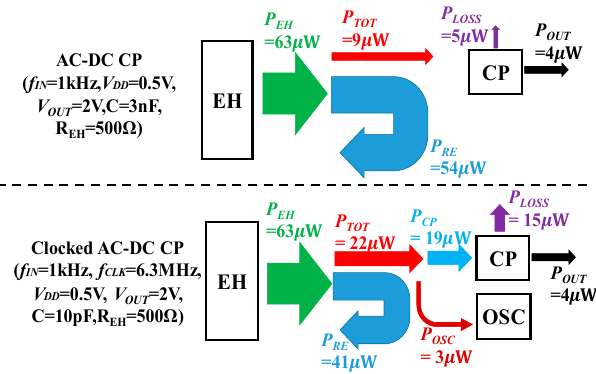
Figure 26. Comparison of power distribution.